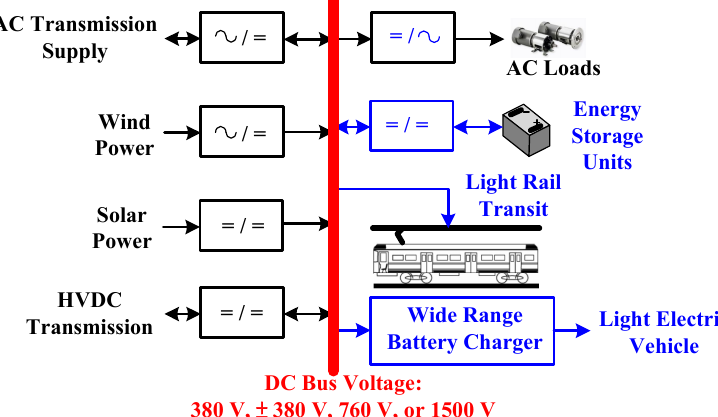
Figure 1. Circuit blocks of a simplified DC microgrid system.